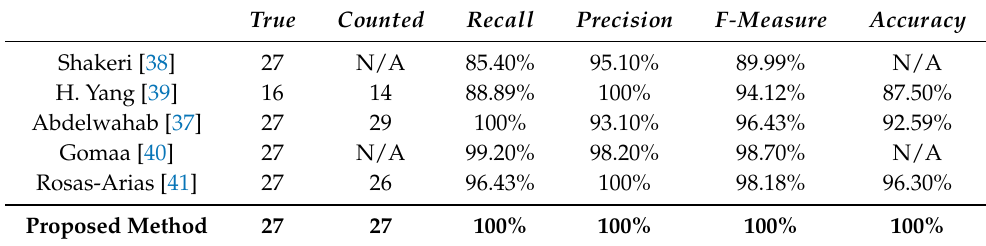
Table 16. Comparison results of the benchmark Highway.